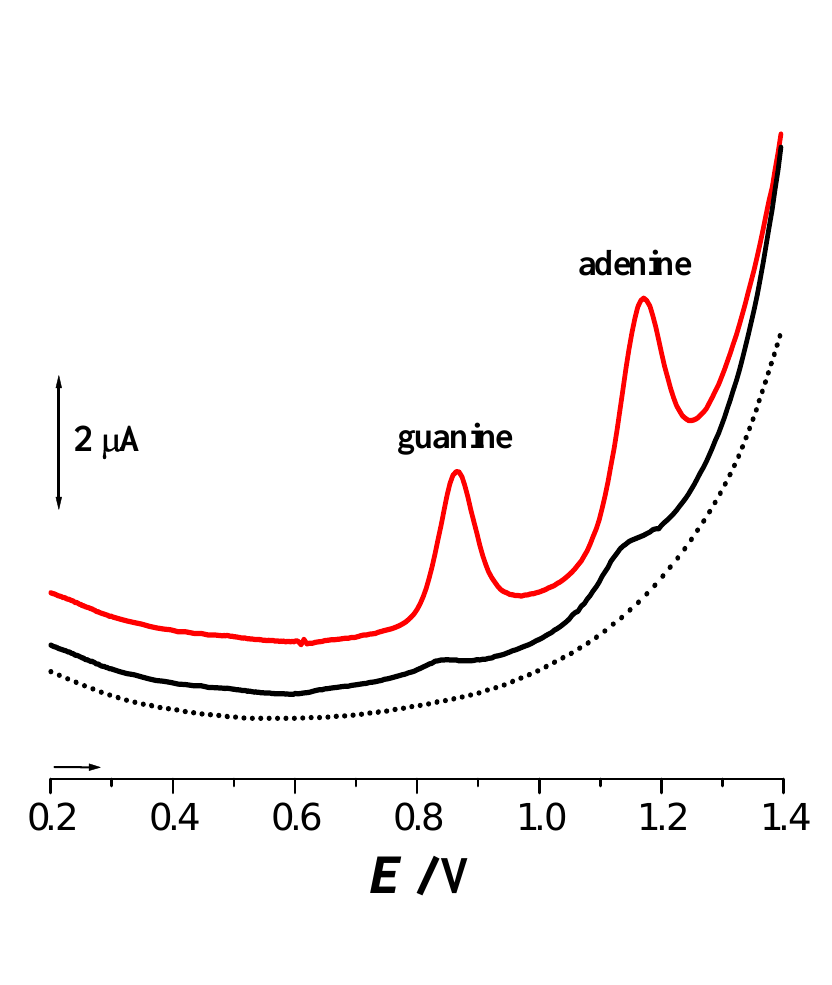
Figure 1. Differential pulse voltammogram obtained with GCE in a solution of pH 4.5 0.1 M acetate buffer of 60 µ g ml -1 : ssDNA - ( ▬ ) 1 st voltammogram and dsDNA - ( (cid:144)(cid:144)(cid:144)(cid:144) ) 1 st and ( ▬ ) 40 th voltammogram [From Ref [7] with